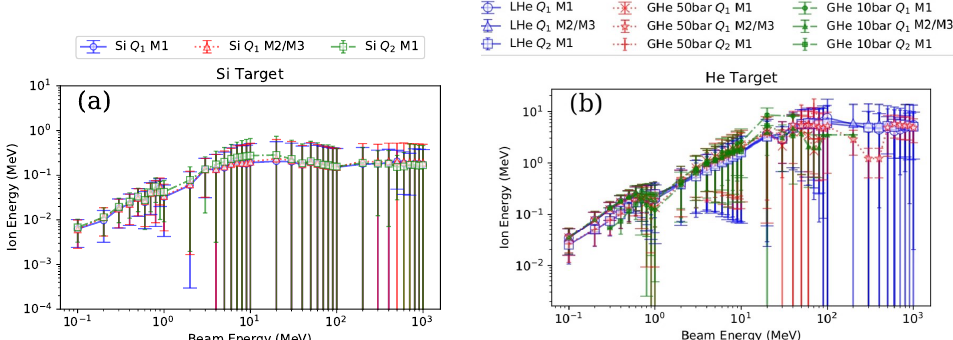
Figure 9. The energy of the ion with the momentum Q 1 and Q 2 . ( a ) The energy scale is about 0.2 MeV and below in the silicon target. ( b ) The energy scale is about 10 MeV and below in the helium target. Figure 10 shows the distribution of the cos Θ 1 . Figure 11 shows the cos Θ of Θ 1 and Θ Θ is close to zero, i.e., the 2 . While the beam energy is below 1 MeV, the mean of cos elastic scattering can be any angle. When the beam energy increases above 1 MeV, the mean of cos Θ is positive, i.e., the angle is less than 90 ◦ and the scattered particle tends to move forward. For the beam energy larger than 100 MeV, cos Θ ∼ 1, which means that the scattering angles are extremely small and the scattered particles just fly forward.